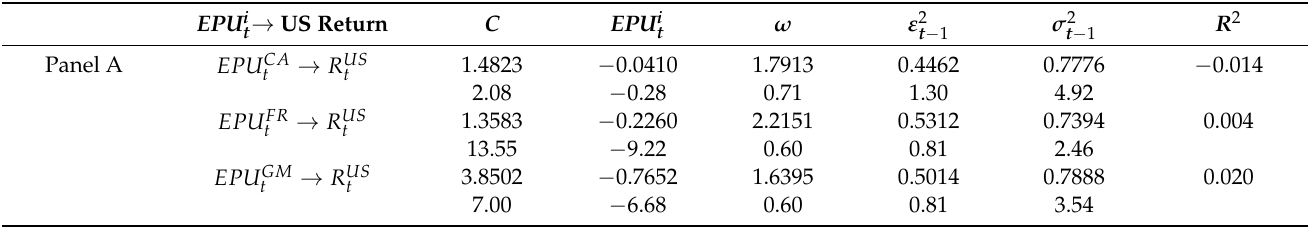
Table 3. U.S stock return in response to each global economic policy